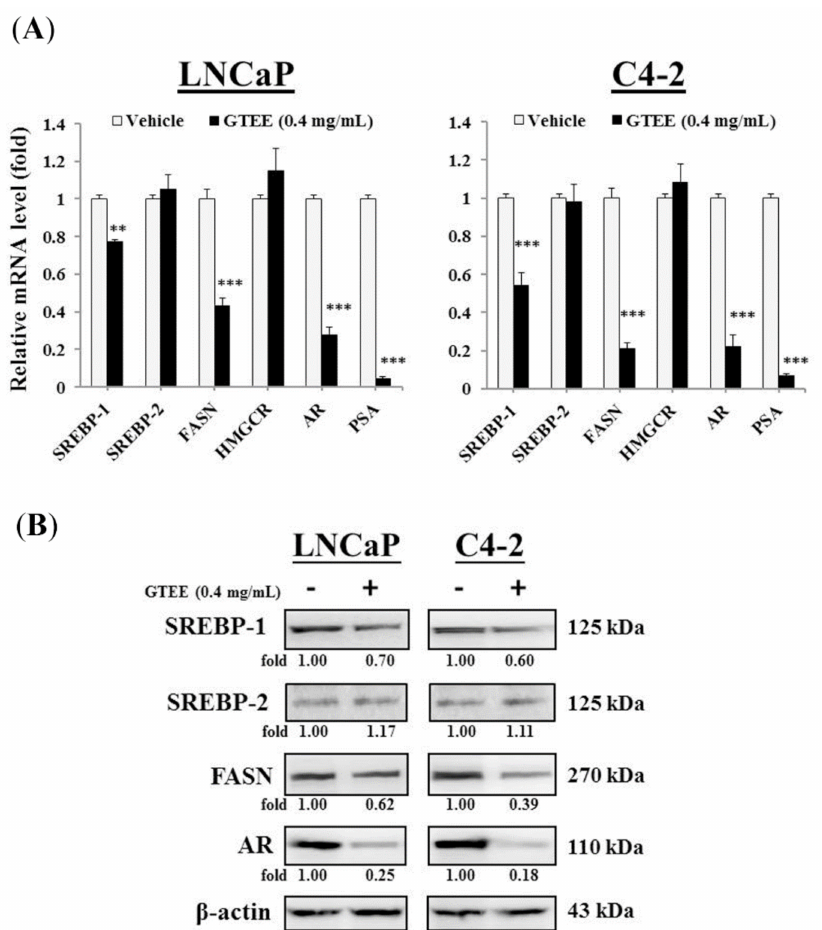
Figure 1. Ganoderma tsugae ethanol extract (GTEE) inhibits the expression of SREBP-1 and its downstream related genes in prostate cancer (PCa) cells. ( A ) GTEE significantly inhibited the mRNA expression of SREBP-1, FASN, AR, and PSA but not SREBP-2 and HMGCR in both LNCaP and C4-2 PCa cells determined by quantitative Reverse Transcription-Polymerase Chain Reaction (qRT-PCR) analysis. The relative mRNA level (fold) was assigned as 1.0 in vehicle-treated cells. Data were normalized to β -actin and represented as the mean ± SD of three independent duplicate experiments. ** p < 0.01, *** p < 0.001. ( B ) GTEE suppressed the protein levels of SREBP-1, FASN, and AR, but not SREBP-2 in LNCaP, and C4-2 cells assayed by Western blot analysis. β -actin was used as a loading control. The protein bands were scanned and quantified using ImageJ software. The relative level (fold) of protein expression with the vehicle treatment and normalized to β -actin was assigned as